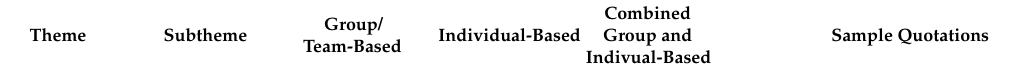
Table 2. Summary of themes and subthemes from included